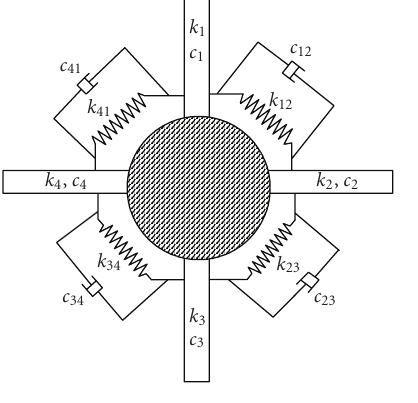
Figure 2: Assembly with four blades.